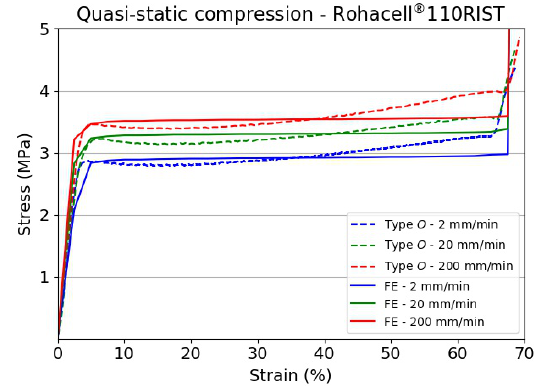
Figure 14. Comparison between numerical and experimental results for specimen Type O (Rohacell R (cid:13)